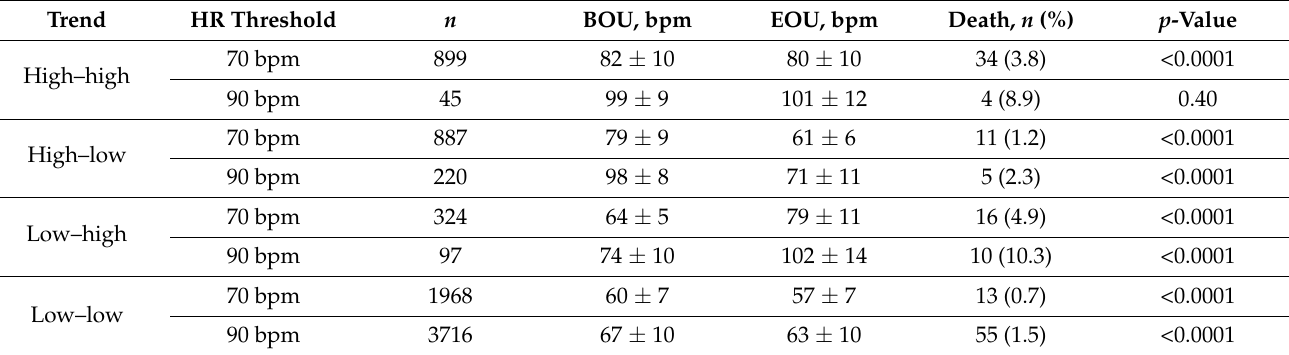
Table 4. Nighttime HR trend with different thresholds.